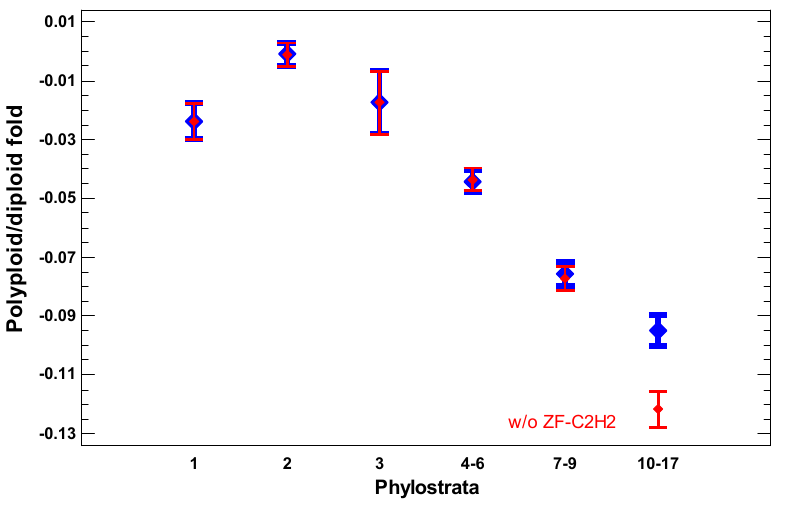
Figure 5. The evolutionary profile of gene expression fold in polyploid/diploid cancers (‘pan- cancer’, the data integrated over about 10,000 cancer samples). The data without ZF-C2H2 genes are shown in red. The strong activation of C2H2-ZF genes in polyploid cancer cells can be seen. Phylostrata: 1—cellular organisms (Prokaryota); 2—Eukaryota; 3—Opisthokonta; 4—Metazoa;